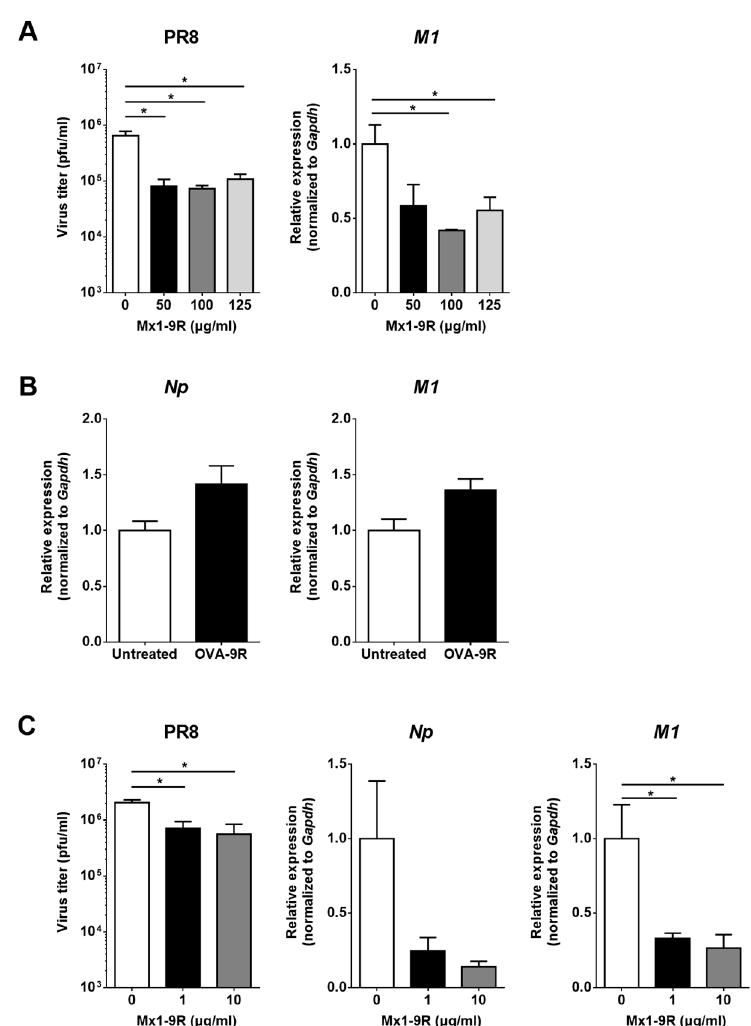
Figure 3. Mx1-9R inhibited influenza virus replication in infected cells. Mx1-9R was introduced into the MDCK cells ( A ) 12 h prior to or ( C ) 3 h post PR8 infection. Viral titers in the culture supernatant were determined by plaque assay, and relative levels of vRNA were analyzed by RT-qPCR ( n = 3). Data are presented as the means ± SEM. ( B ) Recombinant 9 arginine conjugated ovalbumin (OVA-9R) was introduced into the MDCK cells 12 h prior to PR8 infection. Then, cells were infected with 0.01 MOI of PR8 for 24 h, and relative levels of vRNA were analyzed by RT-qPCR ( n = 3). Data are presented as the means ±